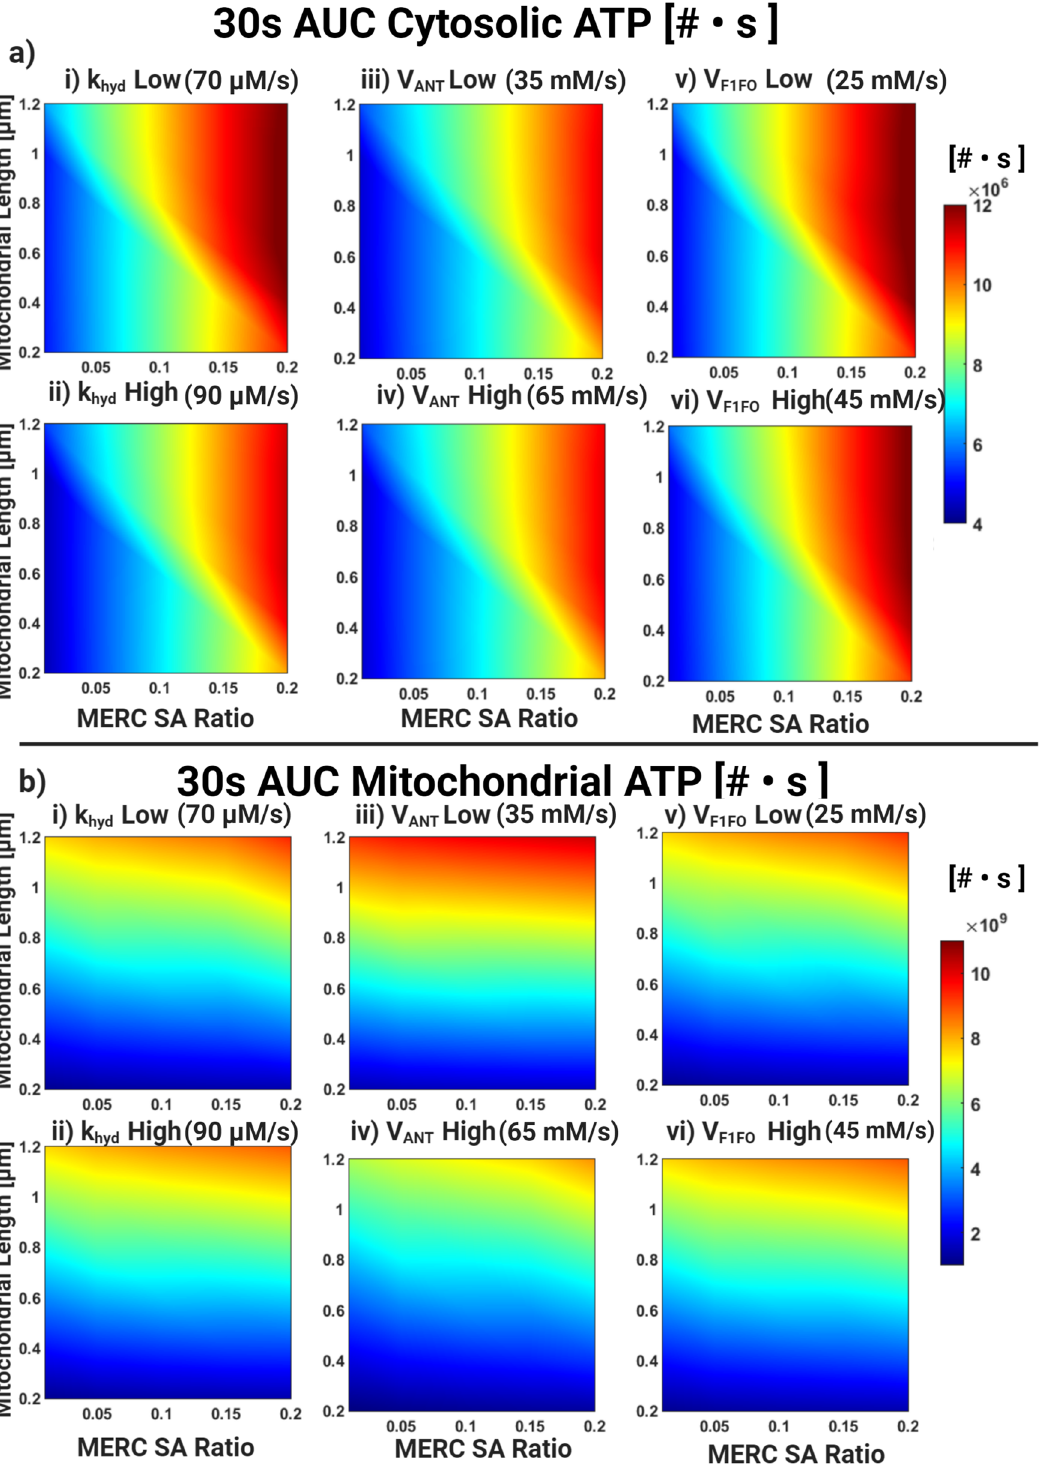
Fig. 7 Phase diagram for AUC of ATP for 30 s post-stimulus with varying metabolic parameters. a Cytosolic ATPAUC phase map for i ) k HYD = 70 μ M / s , ii ) k = 90 μ M/s, iii ) V = 35 mM / s , iv ) V = 65 mM / s , v ) V = 25 mM / s , vi ) V = 45 mM / s . b ) Same as ( a ) for mitochondrial HYD ANT ANT F 1 FO F 1 FO